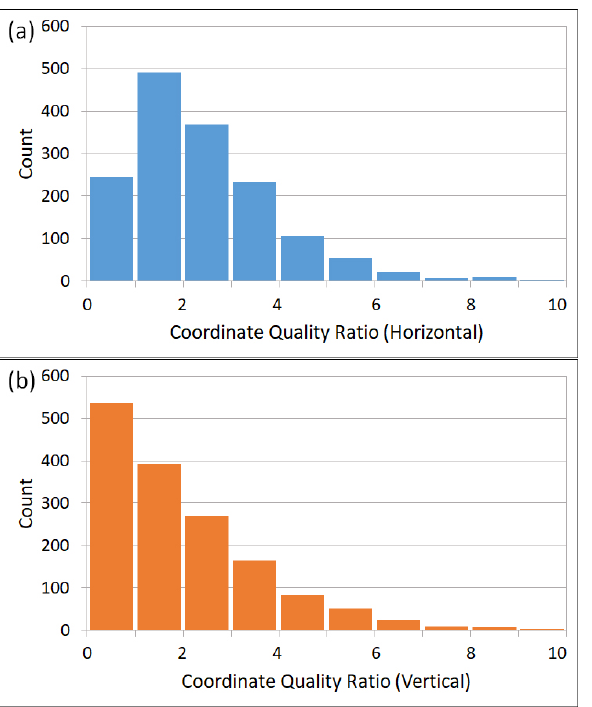
Fig. 5. Calculated (a) HPU and (b) VPU for NRTK observations based on CQ output scaled by a factor of